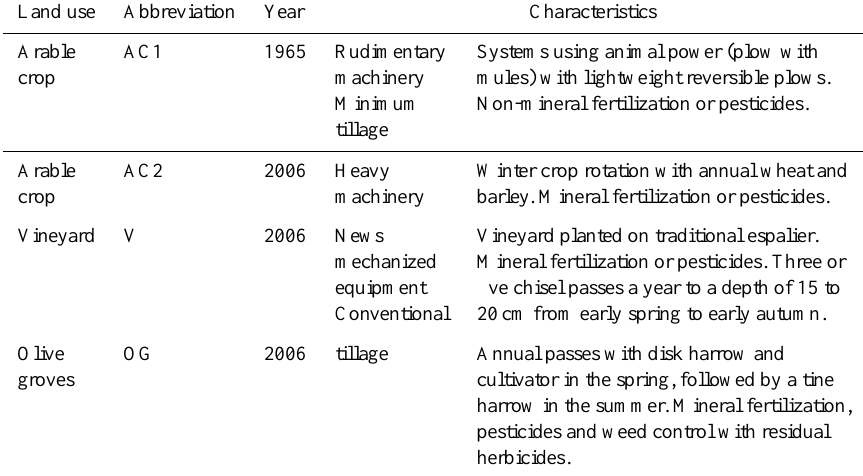
Table 1. Land use categories and class in Montilla-Moriles DO. Land use